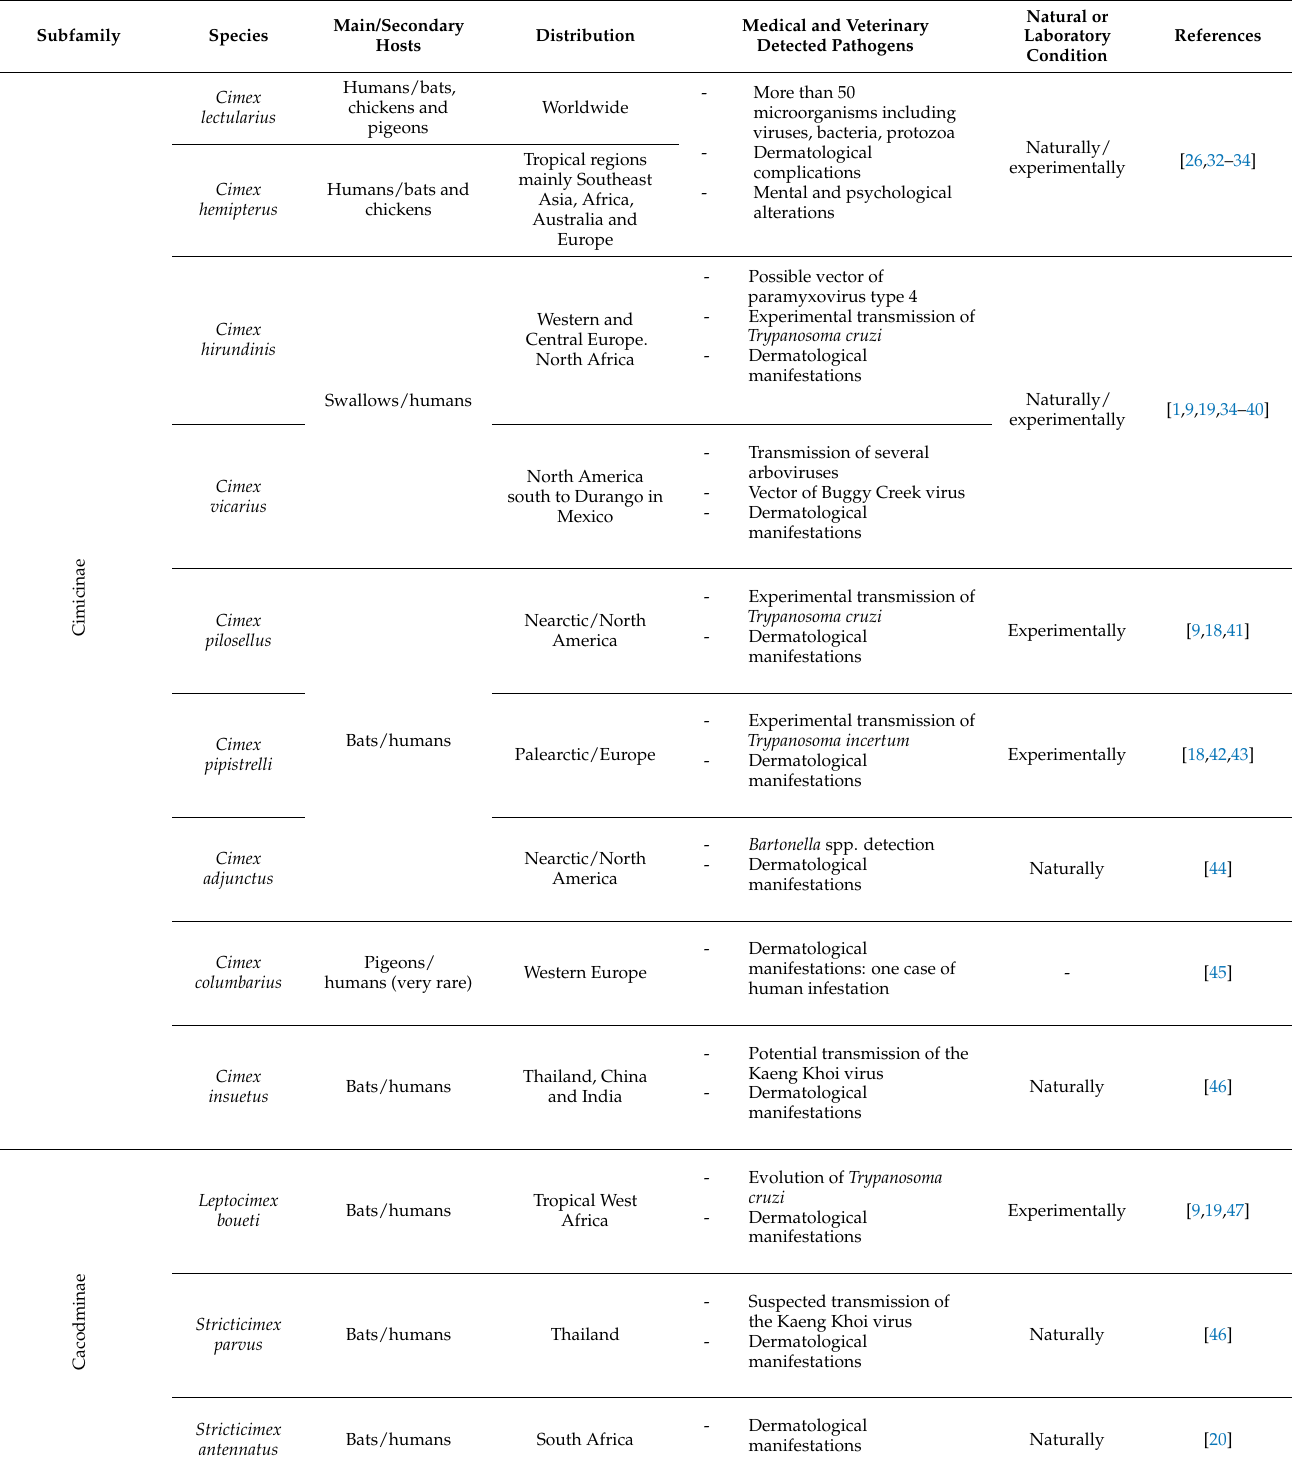
Table 1. Summary of Cimicidae of medical and veterinary